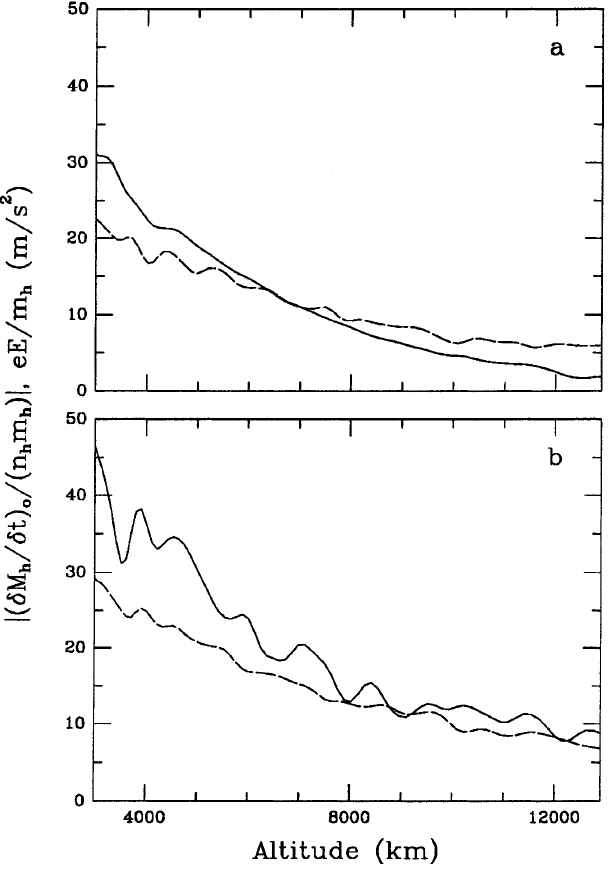
Fig. 20. Comparison of H (cid:135) deceleration due to H (cid:135) -O (cid:135) Coulomb collisions ( solid ) with its acceleration due to the ambipolar electric field ( dashed ). Note that ( (cid:100) M h = (cid:100) t (cid:134) = (cid:133) n h m h (cid:134) , which is the average o deceleration of an H (cid:135) ion due to H (cid:135) -O (cid:135) collisions, is negative throughout the altitude range, while eE = m h is always positive . The labels ( a ) and ( b ) correspond to the cases listed in